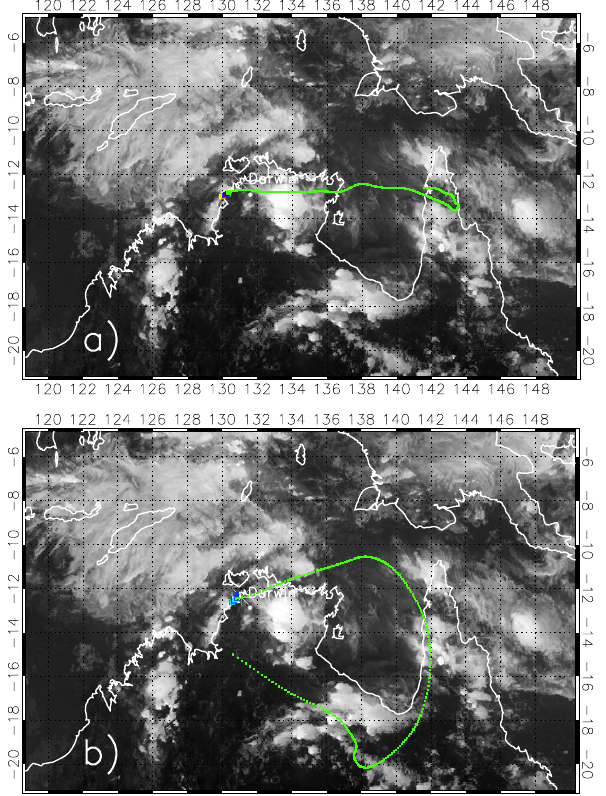
Fig. 6. 5-day backward trajectories from transects 4 (a) and 8 (b) overlaid on 07:30UTC MTSAT IR satellite images of 22 January.